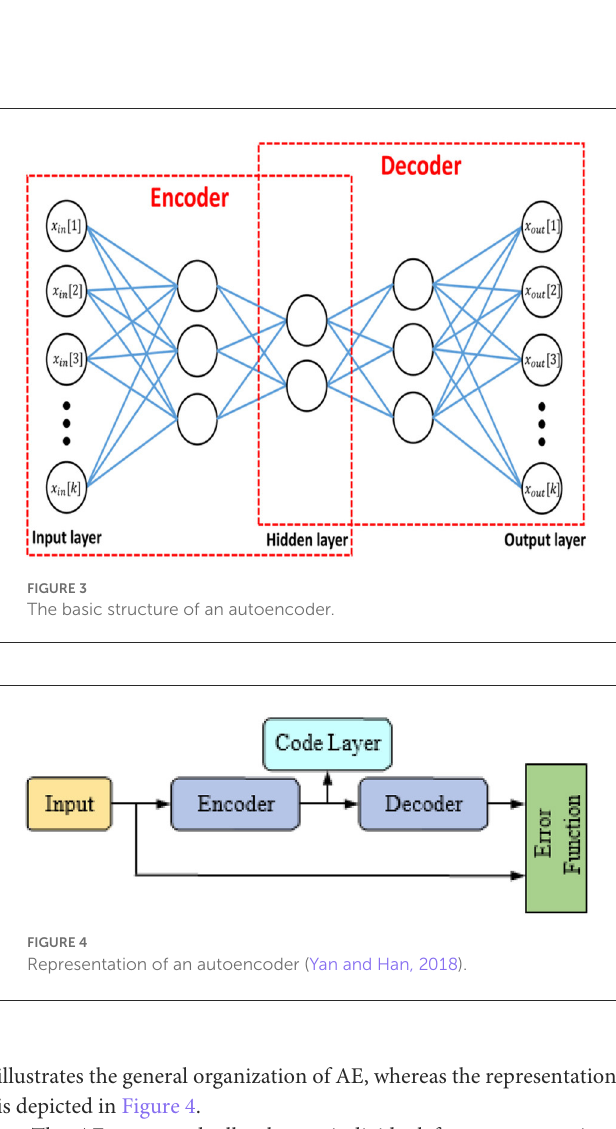
illustrates the general organization of AE, whereas the representation is depicted in Figure